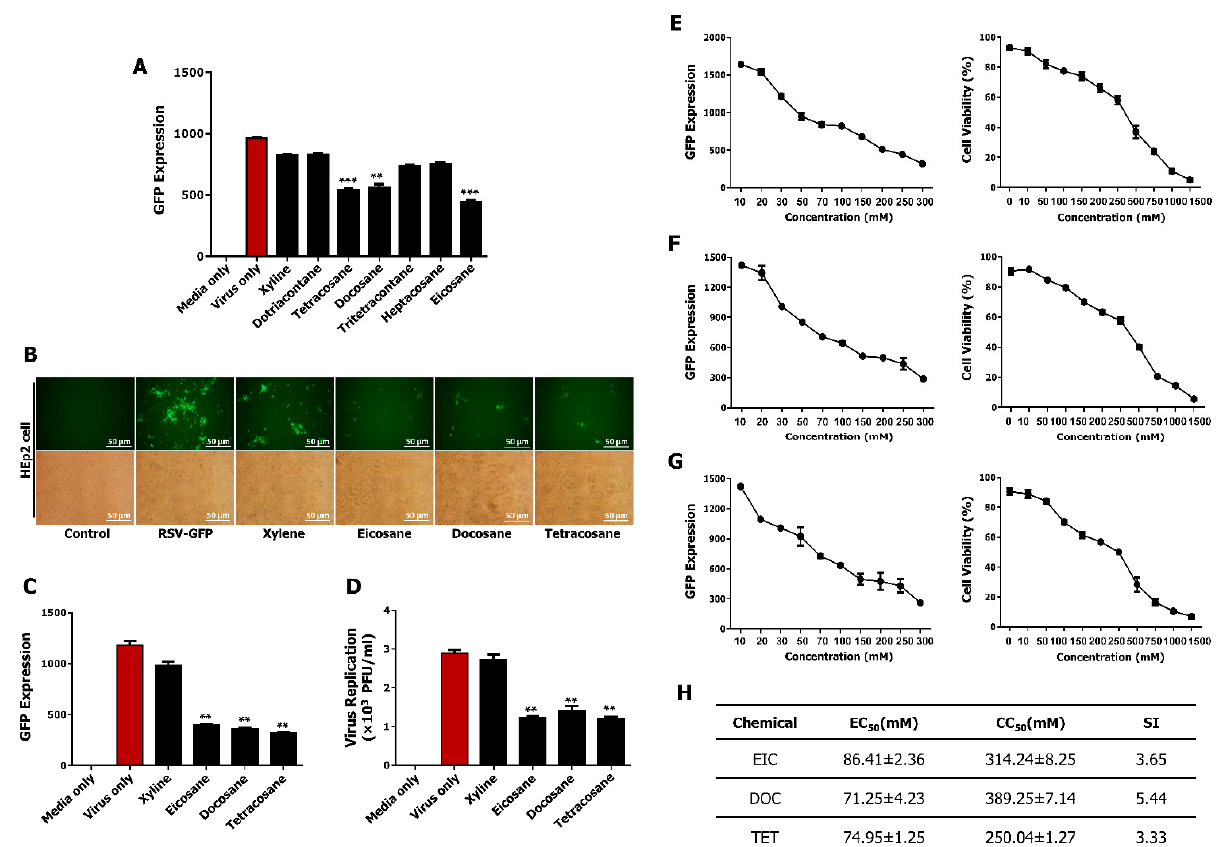
Figure 4. Identification and antiviral effect of eicosane (EIC), docosane (DOC) and tetracosane (TET) in vitro. A monolayer of HEp2 cells was infected with RSV–GFP (0.1 MOI) for 2 h with DMEM containing 1% FBS. Then, the medium was replaced with DMEM containing 10% FBS, and cells were treated with 100 mM of given chemicals. ( A ) GFP absorbance levels were measured by Glomax multi-detection luminometer (Promega). HEp2 cells were infected with 0.1 MOI of RSV–GFP and 2 hpi cells were treated with 100 mM of EIC, DOC, and TET. ( B ) Cell images were obtained (200 × magnification) with a fluorescence microscope. ( C ) Fluorescence absorbance level was determined with Glomax multi-detection luminometer. ( D ) RSV–GFP titration was performed by standard plaque assay. ( E – G left panels) The amount of chemical required for reduction of 50% GFP absorbance value was considered as EC 50 value. ( E – G right panels) CC 50 values of the three chemicals were determined. Cell viability was determined by Cell counting kit-8 assay. ( H ) Selectivity index (SI) CC 50 /EC 50 . Scale bar-50 µ M. Results indicate the values obtained from counting duplicates in three independent experiments (** p < 0.01 *** p < 0.001 regarded as significant difference).